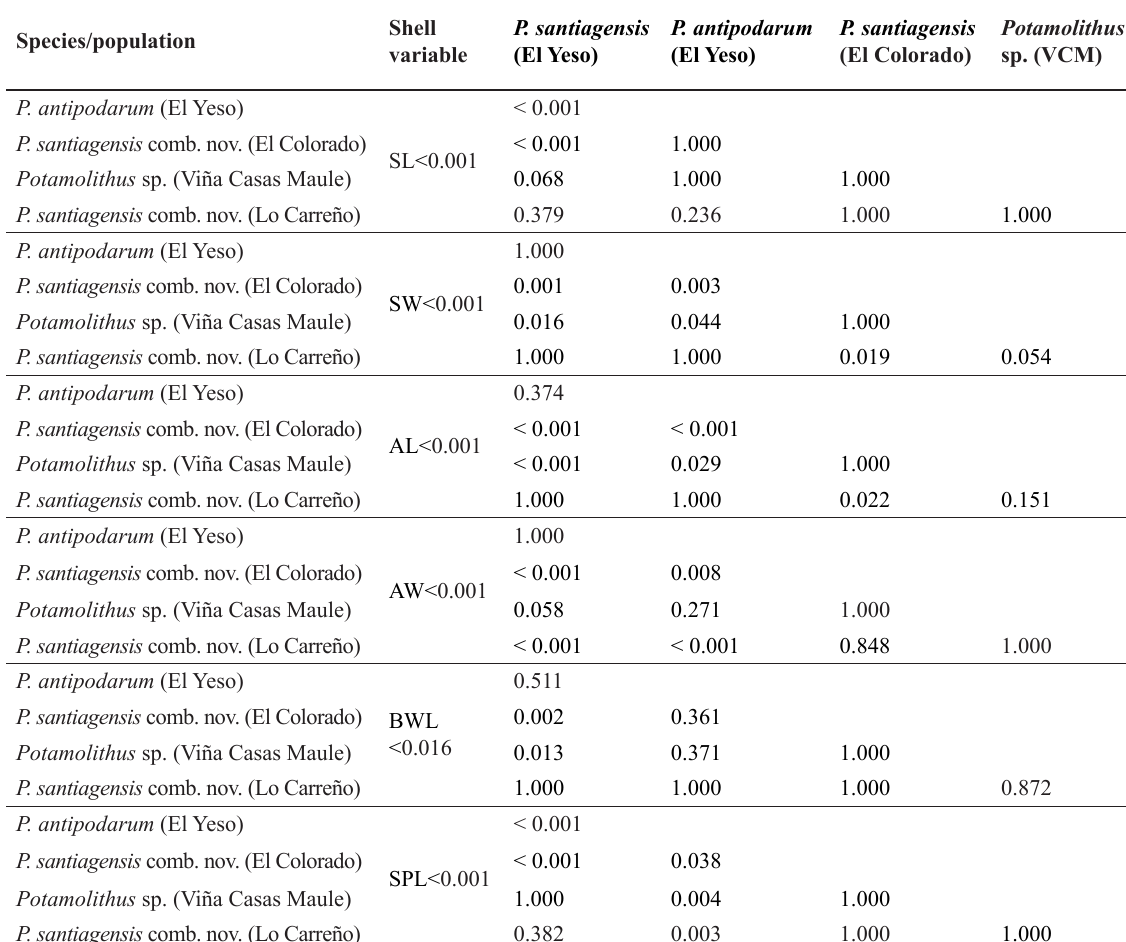
Table 2. P-values of Kruskal-Wallis (in column Shell variable) and pairwise post-hoc Mann-Whitney U-tests of six linear